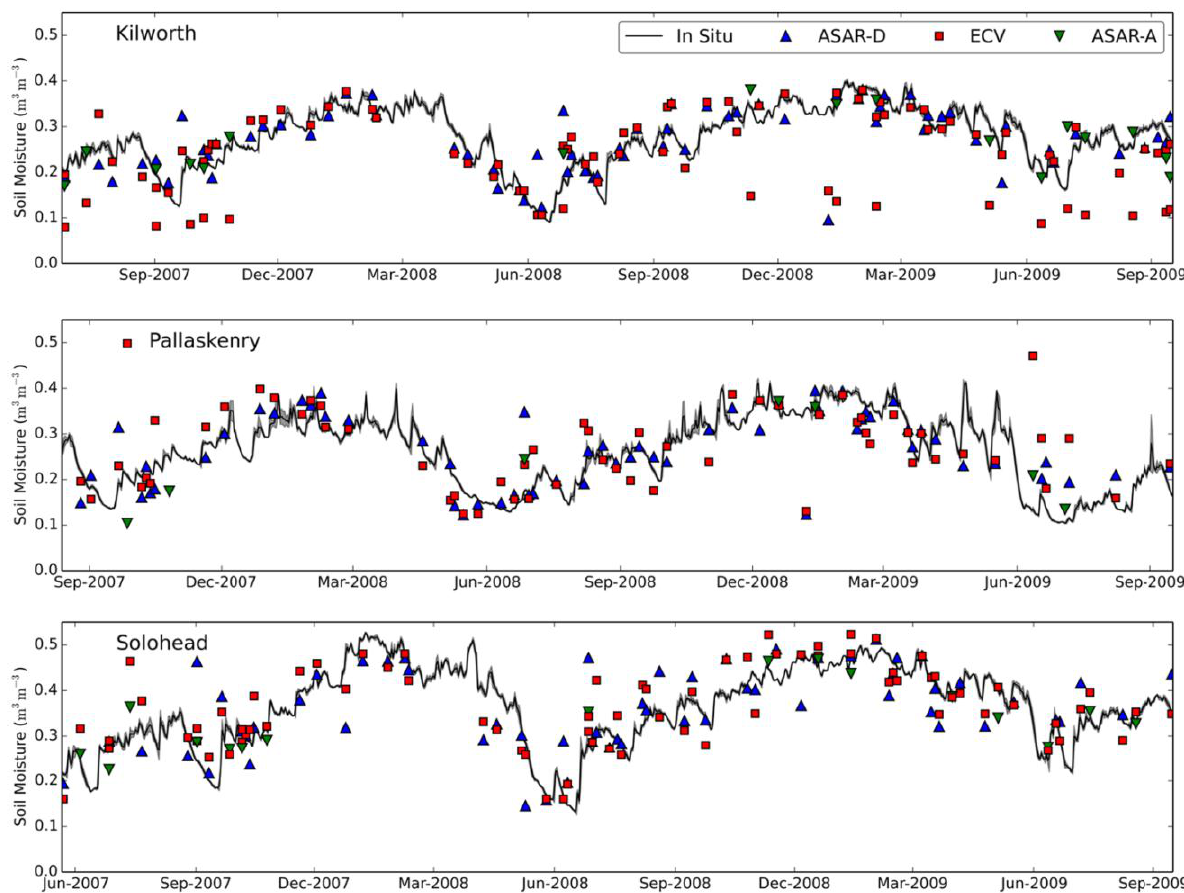
Figure 3. Time series of in situ (continuous black line), ASAR (descending (blue triangle) and ascending (green triangle) passes), and ECV (red square) soil moisture values for each Irish ECV cell.